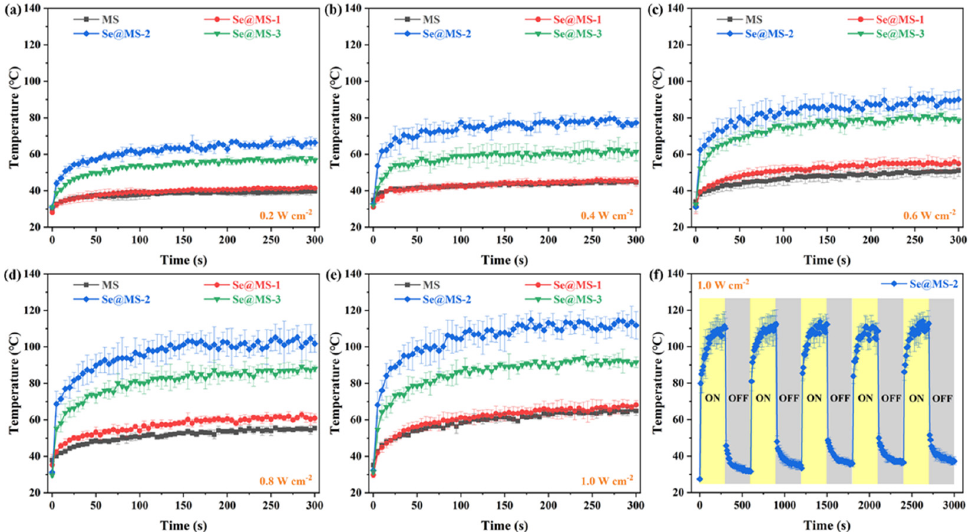
Figure 5. Photothermal performance of Se@MS. Surface temperature variations of pristine MS, Se@MS-1, Se@MS-2, and Se@MS-3 under illumination at different power densities: ( a ) 0.2 W cm − 2 ; ( b ) 0.4 W cm − 2 ; ( c ) 0.6 W cm − 2 ; ( d ) 0.8 W cm − 2 ; and ( e ) 1.0 W cm − 2 . ( f ) Five on/off temperature cycles of Se@MS-2 under illumination at 1.0 W cm − 2 .